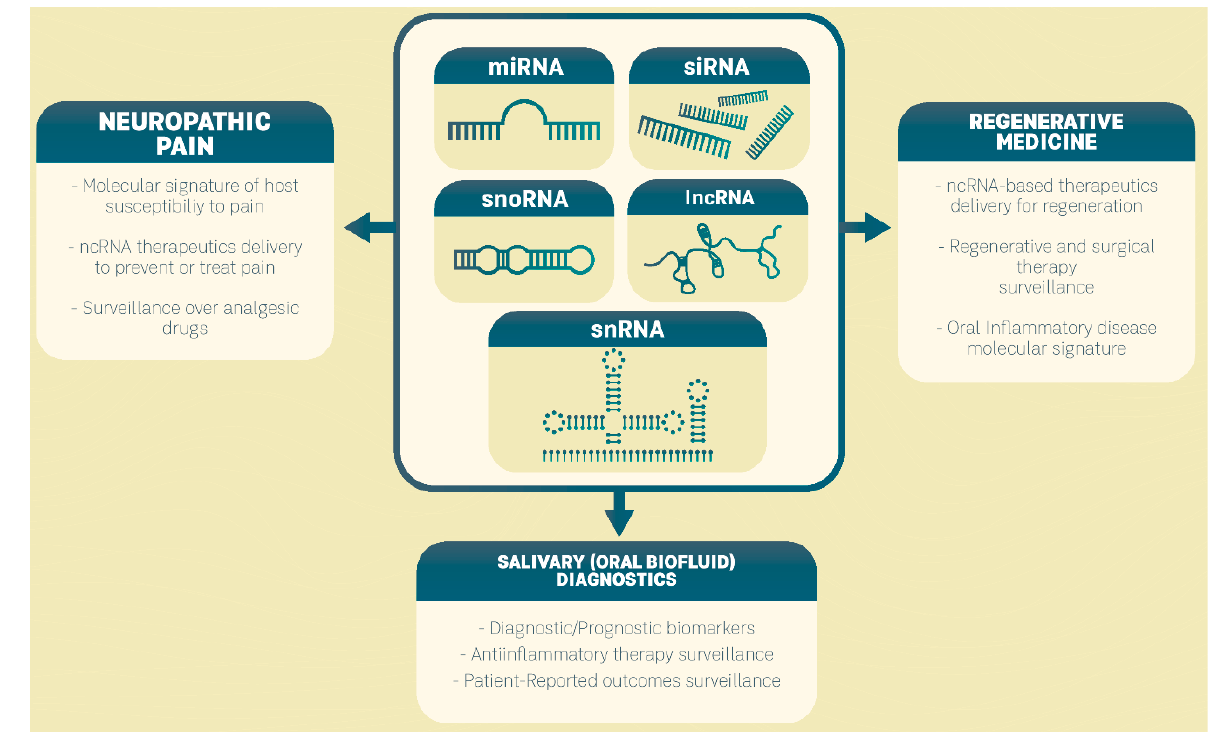
Figure 1. Clinical perspectives of ncRNAs in precision medicine of oral inflammatory diseases.